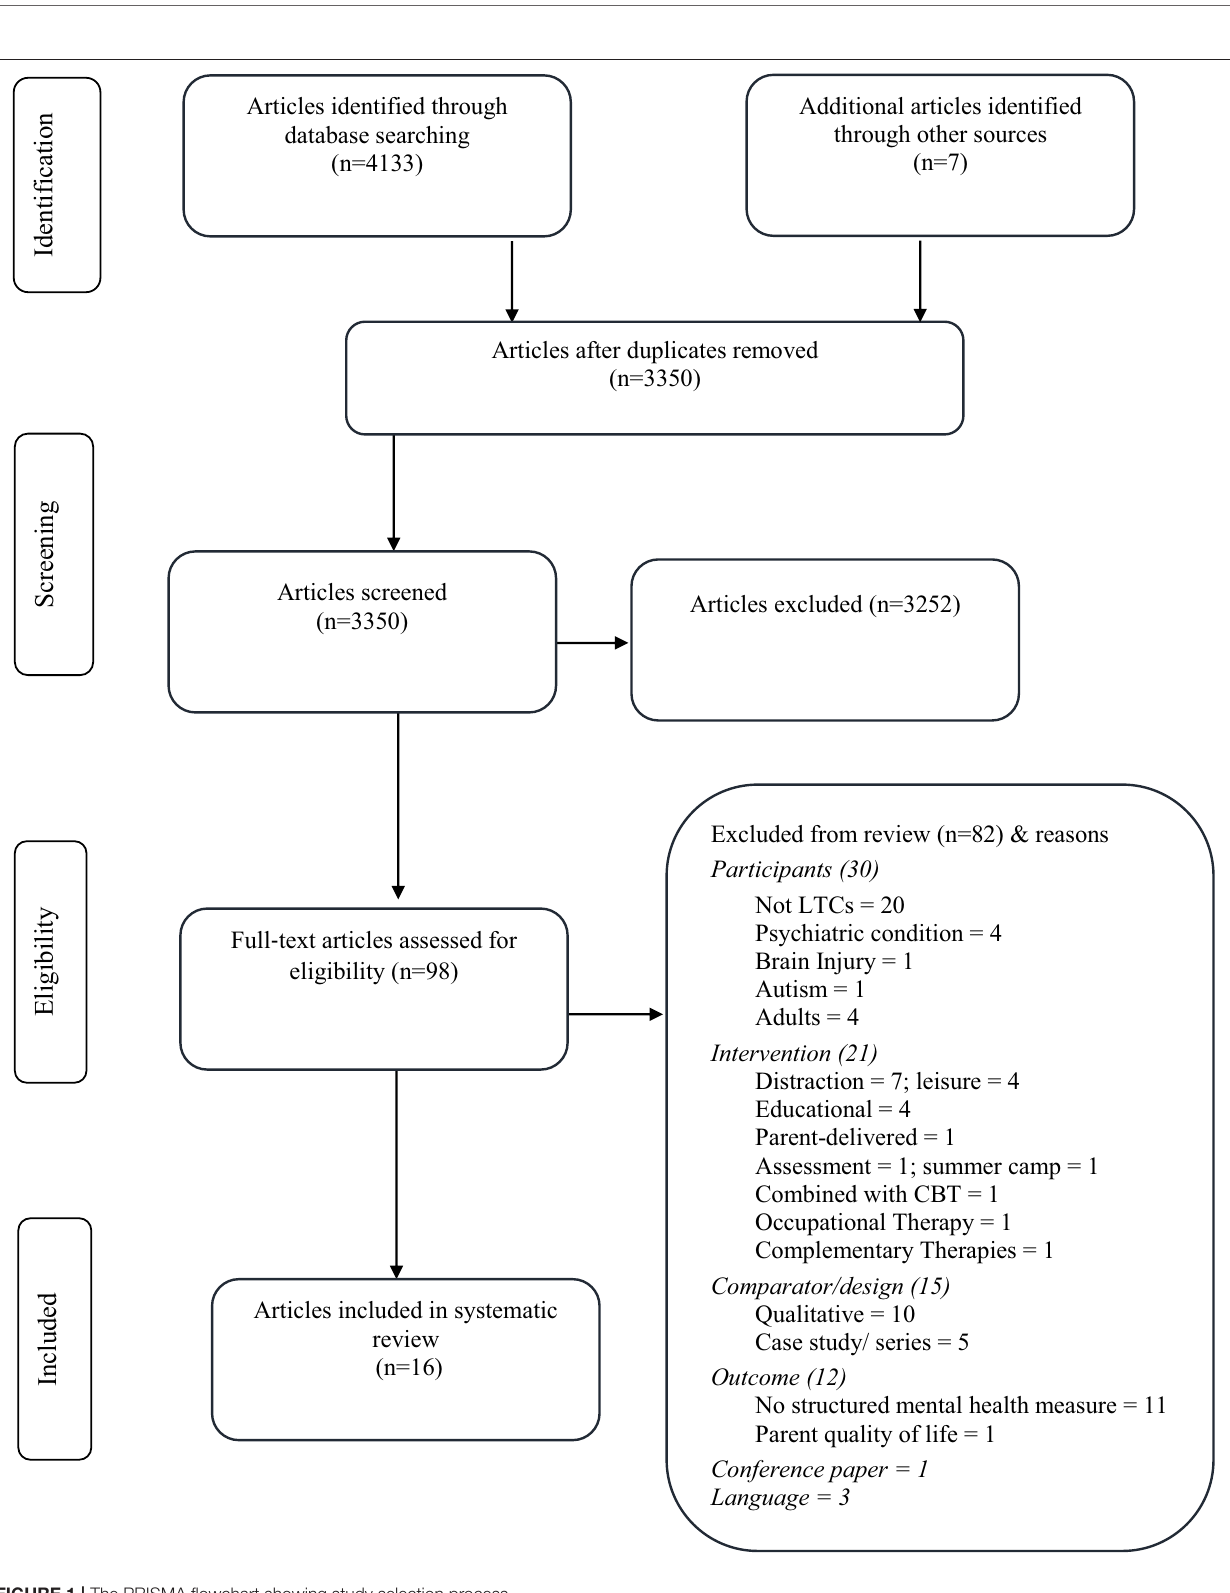
Frontiers in Psychology |